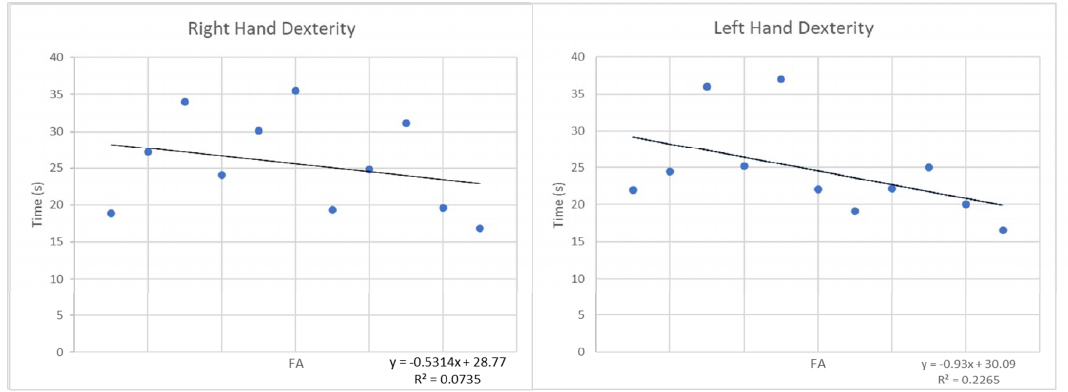
Figure 6. Correlation between the postoperative FA values and hand dexterity.